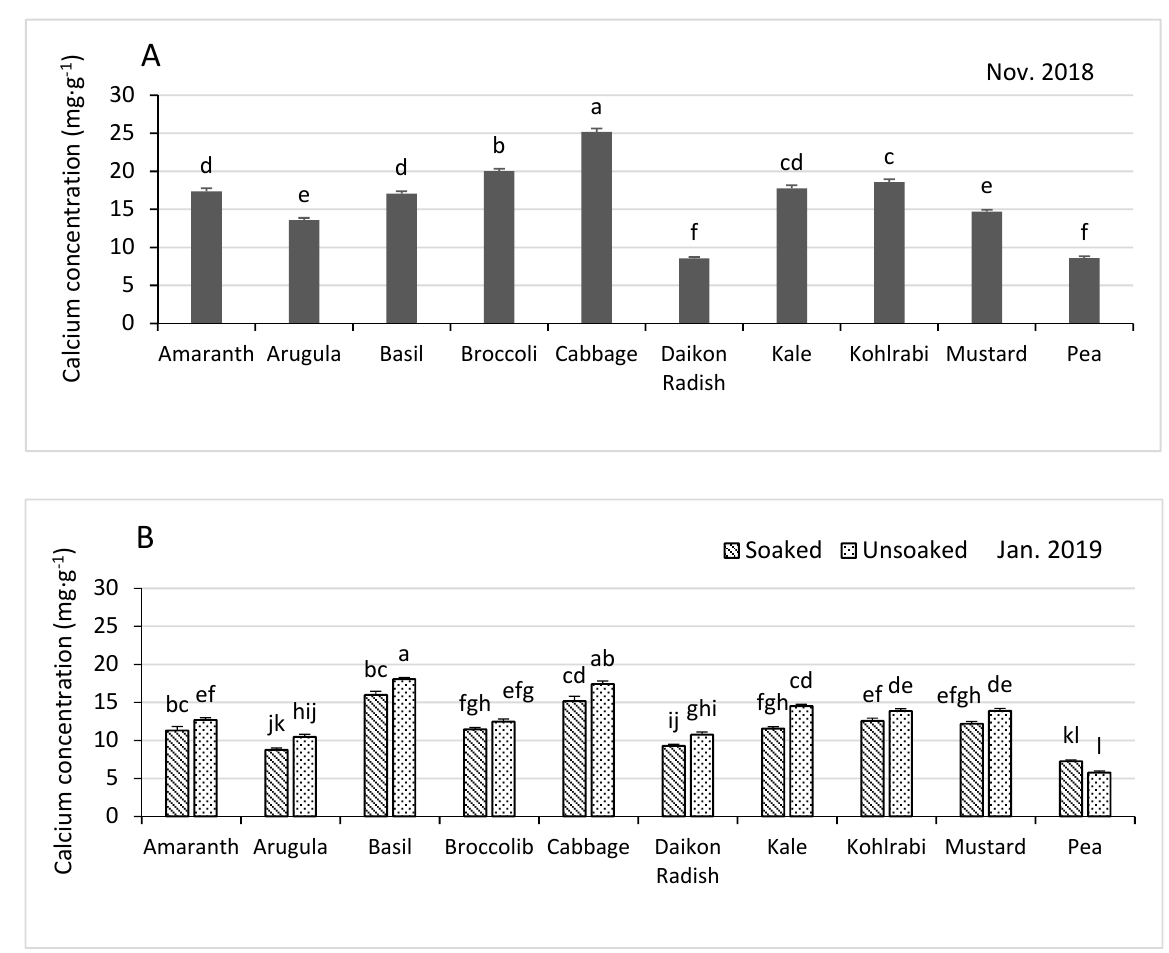
Figure 4. Calcium concentrations on a dry weight basis in ten microgreens affected by the main effect of species in November 2018 ( A ) or by the interaction between species and seed soaking in January 2019 ( B ). Means with standard error bars of each species were obtained by averaging data from both fertilization and pre-sowing seed treatments ( A ), or by averaging data from both fertilization treatments ( B ). Different lowercase letters within a chart suggest significant difference among treatments indicated by Tukey’s HSD test at α ≤ 0.05.